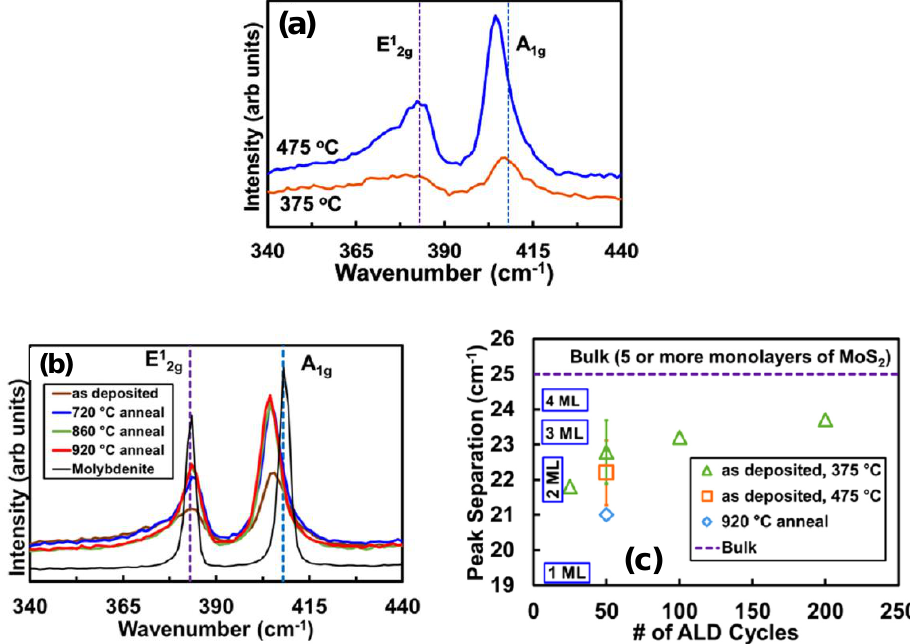
Figure 6. ( a ) Raman spectroscopy measurements of ALD MoS 2 at 375 or 475 °C , where the latter shows higher quality. ( b ) Raman spectra of 475 °C deposited MoS 2 films (some are post annealed in sulfur environment), where 920 °C annealing leads to the best quality. The curve for bulk MoS 2 is for reference. ( c ) E 1 2g to A 1g peak separation Δ plotted against the cycle number in ALD. Δ~19 cm −1 tentatively indicates MoS 2 monolayer, whereas bulk (>5 layers) material has Δ~25 cm −1 [56].